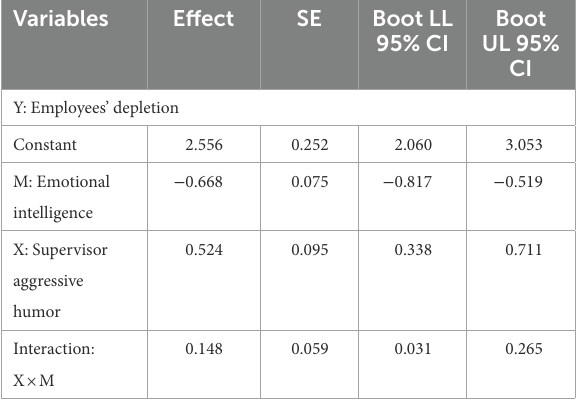
TABLE 4 Emotional intelligence as a moderator in the relationship between supervisor aggressive humor and employees’